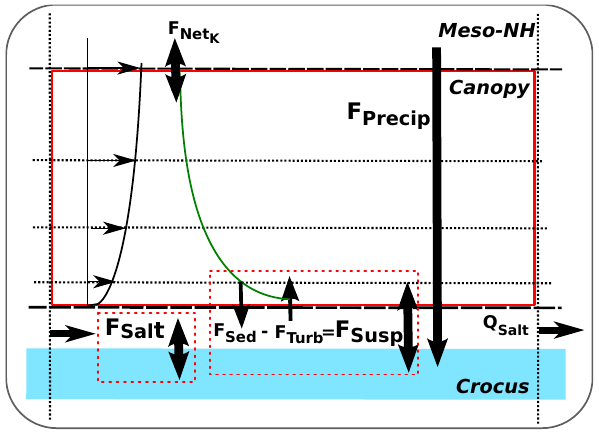
Fig. 2. Mass exchange between the different components of the cou- pled model Meso-NH/Crocus. The model accounts for snow trans- port in saltation ( F Salt ) and turbulent suspension ( F Susp ) and snow- fall ( F Precip